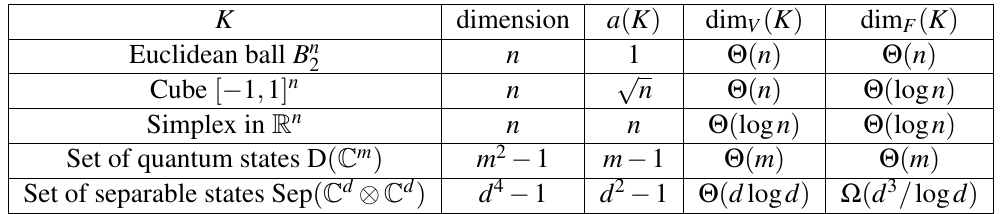
Table 1: Parameters appearing in (6) for some families of convex bodies, see Section 5 for justifications and references. The main technical points of this paper are the estimates from the last two rows on the verticial and facial dimensions of the set of states (Theorem 8) and of the set of separable states (Theorem 9). The bounds implicit in the first three rows are either trivial or well-known and are included here mostly to provide reference